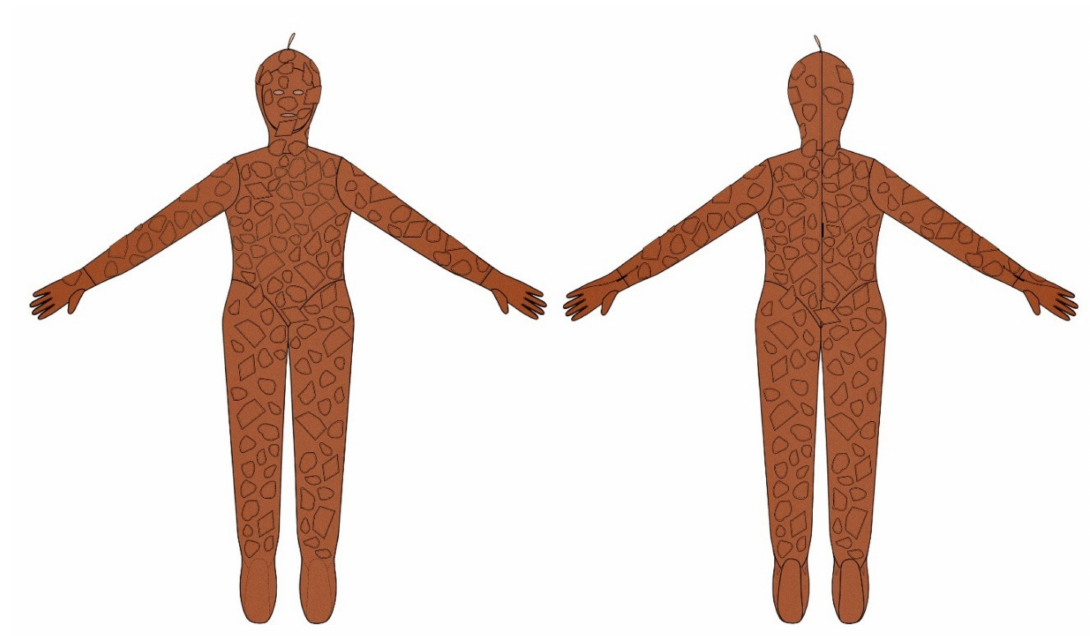
Figure 15. Technical drawing illustrated of the nocturnal thermal camouflage prototype. To sum up, the results of the final thermal tests carried out in the idealized thermal camouflage environment, with the diurnal and nocturnal thermal camouflage prototypes can be observed bellow in Figures 16 and 17, taken from [42].